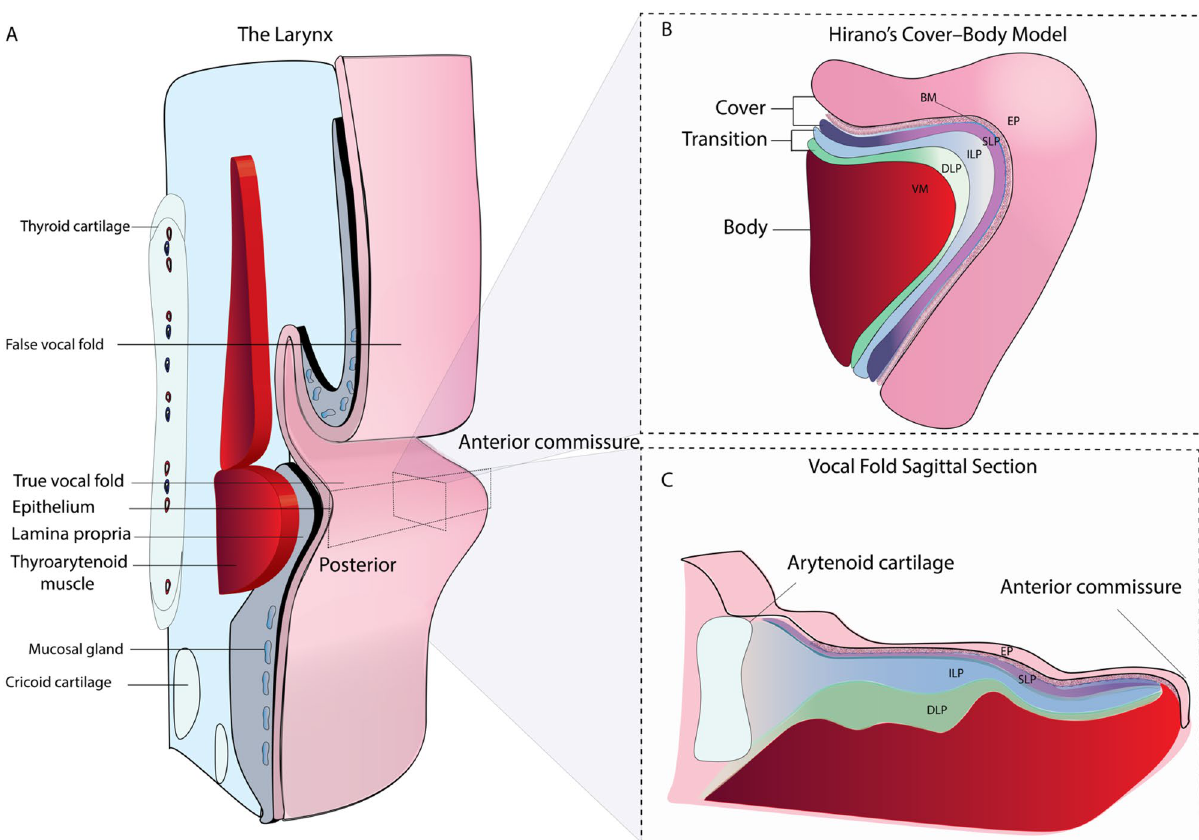
Figure 1. The human larynx. Major anatomical structures of the human larynx representing a complex organization of cartilages, ligaments, and muscles (A) . Attached anteriorly to the thyroid cartilage and posteriorly to the arytenoid cartilages, the true vocal folds are essential to phonation. Their physiology can be described with the cover-body theory of phonation (B) , which groups the epithelium (EP), the basement membrane (BM), and the superficial lamina propria (SLP) as a single entity: the cover, known to be critical for sustaining vibration. The vocal ligament is the transition layer between the cover and body, which include the intermediate lamina propria (ILP) and deep lamina propria (DLP). The body is represented by the thyroarytenoid (TA) muscle. Sagittal sections (anterior to posterior) used in this study allow for a full representation of the VF layered structure (C)